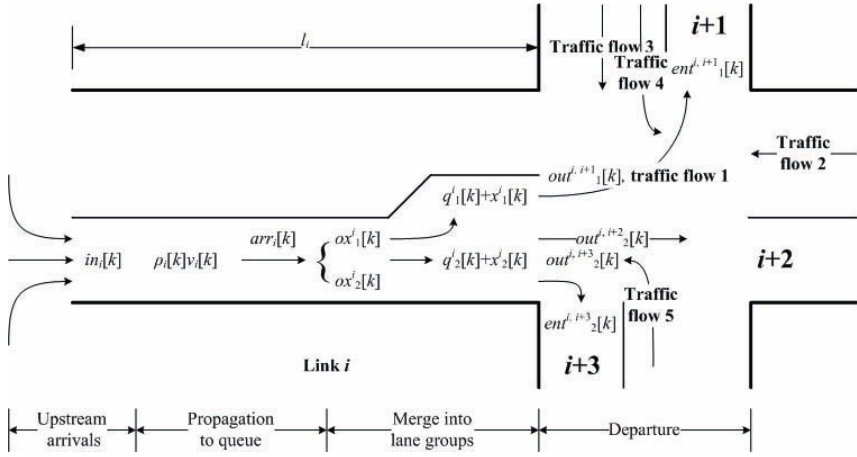
Figure 1. Dynamic traffic flow along a link i . All the movements (including up- stream arrivals, propagation to queue, merge into lane groups and departure) of traf- fic flow are shown in this